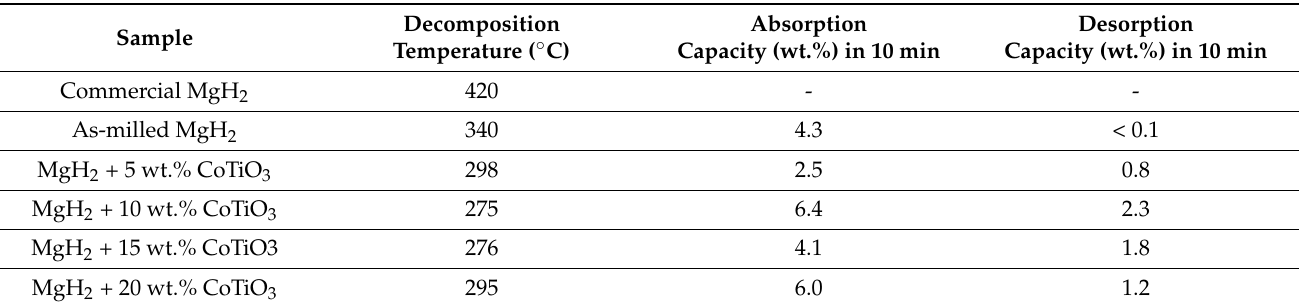
Table 1. The hydrogen storage behavior of undoped and doped MgH 2 with different weight percent- age of CoTiO 3